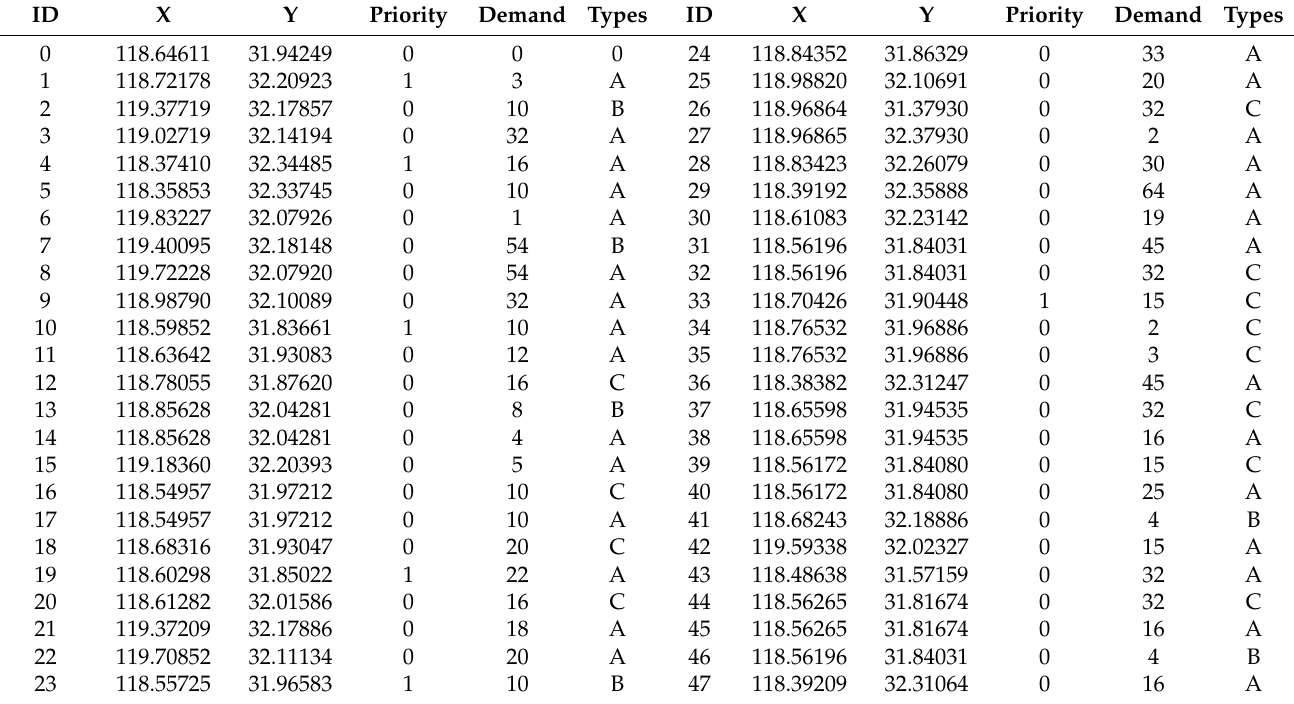
Table 1. Data of customer